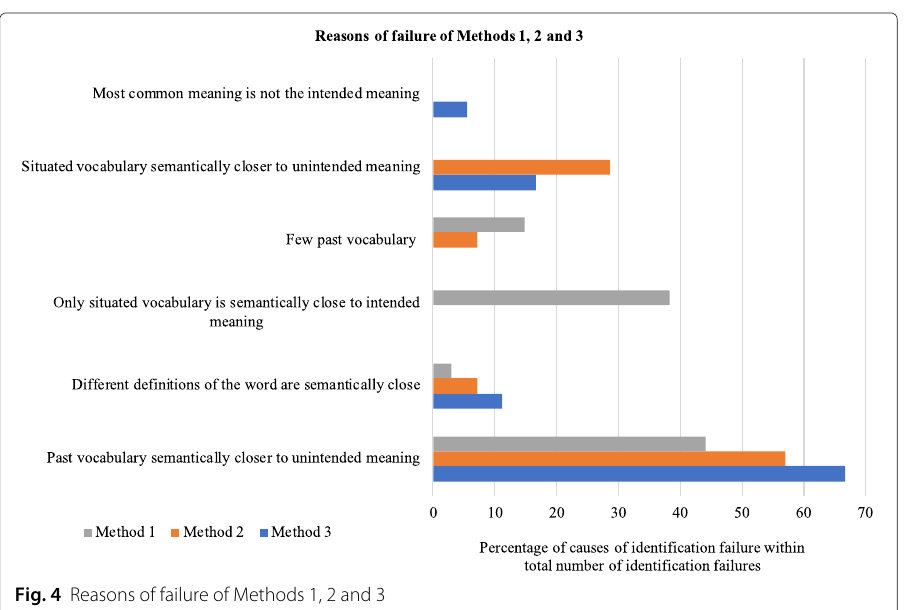
Fig. 4 Reasons of failure of Methods 1, 2 and